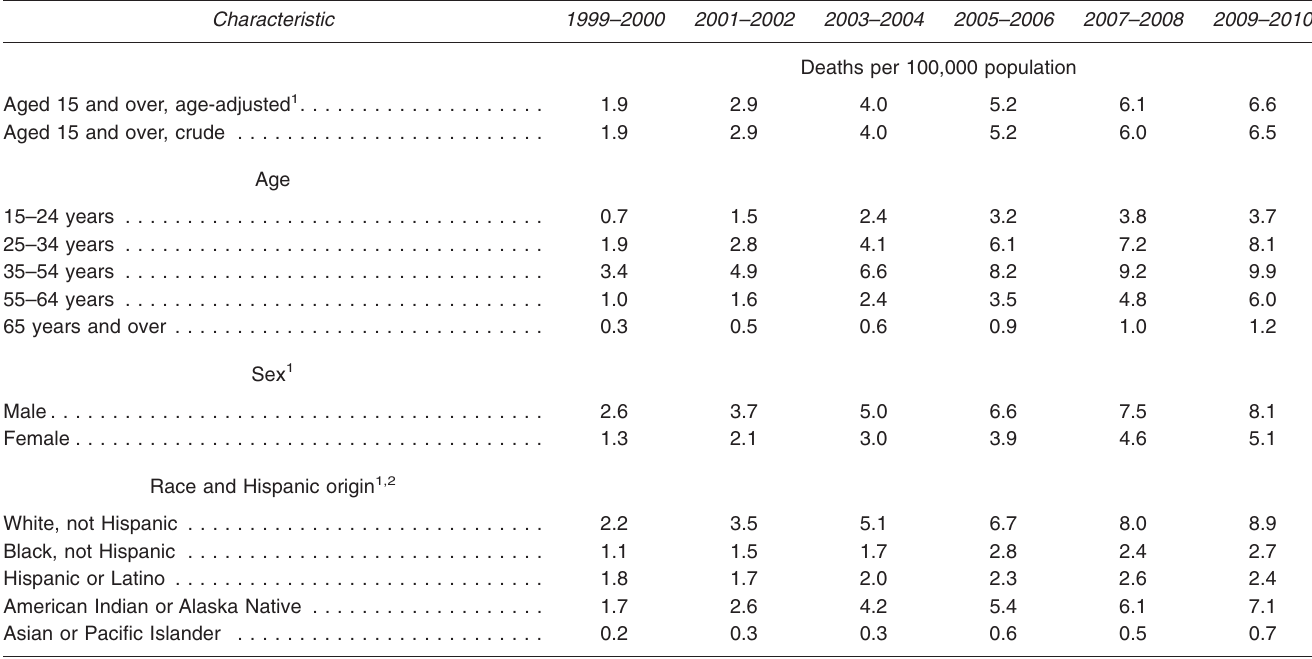
Data table for Figure 28. Drug poisoning deaths involving opioid analgesics among persons aged 15 and over, by race and Hispanic origin, sex, and age: United States, 1999–2000 through 2009–2010 Excel and PowerPoint: